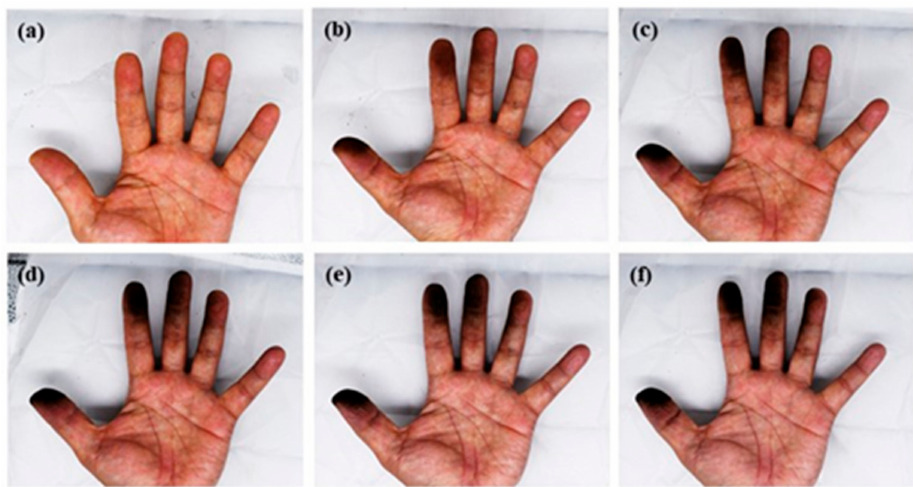
Figure 2. The process of dyeing the hands: After operating ( a ) 0; ( b ) 20; ( c ) 40; ( d ) 60; ( e ) 80; and ( f ) 190 fragments of asexual propagation of S. flexibilis , the hands became gradually darker.